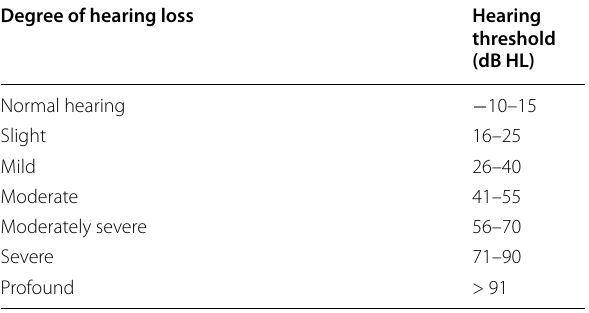
Source [2]: Clark JG: Uses and abuses of hearing loss classification. ASHA. 1981, 23:493–500